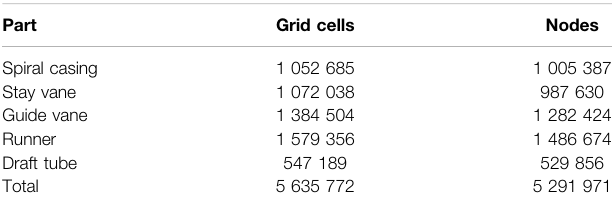
TABLE 2 | Number of grids and nodes.